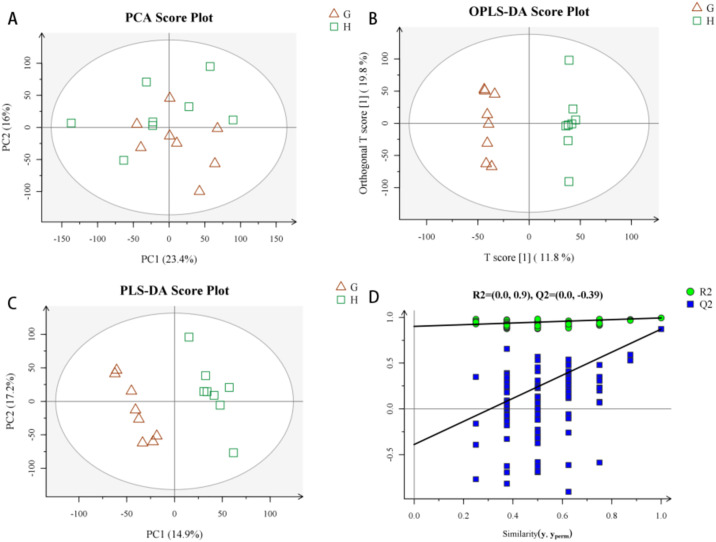
Urine metabolism profile of CAG model rats in negative ion mode.5-A: PCA Scores, 5-B: PLS-DA Scores, 5-C: OPLS-DA Scores, 5-D: Replacement Test of the CAG Model Urine Fit Model in Negative Ion Mode.